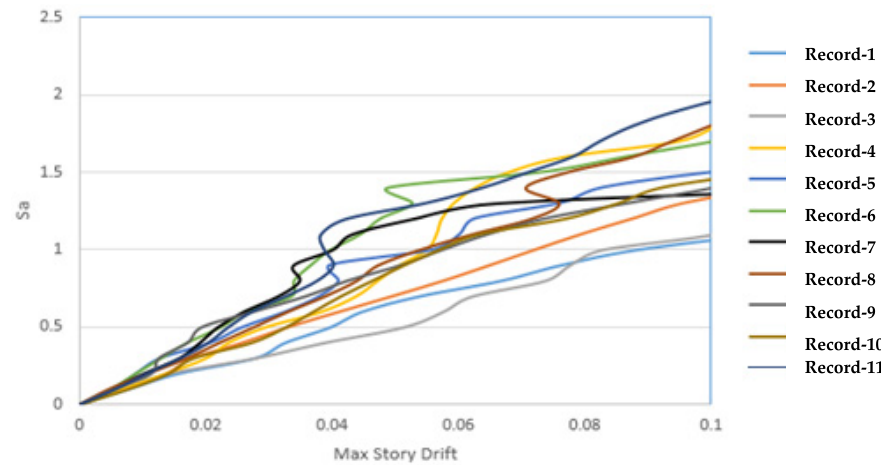
Figure 16. IDA curves obtained for a 15-story building with semi-rigid connections.